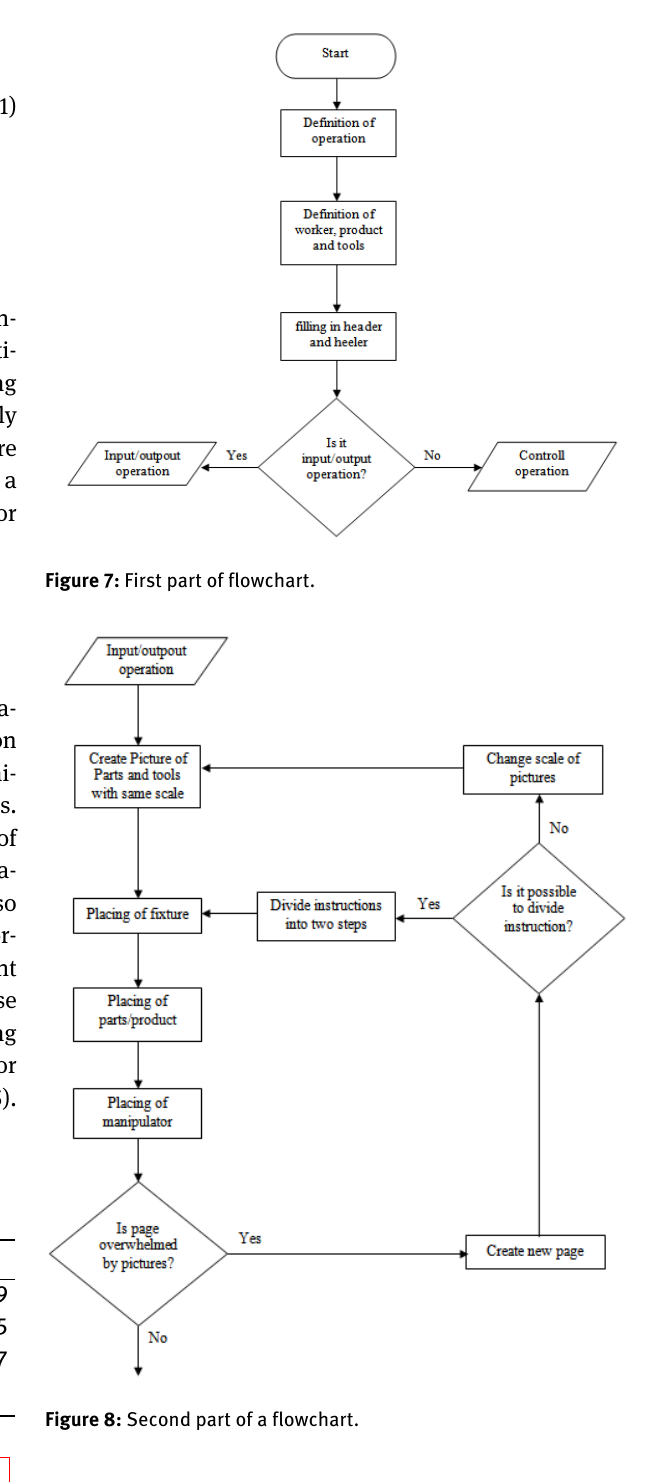
Figure 5: Developed header of work instructions.